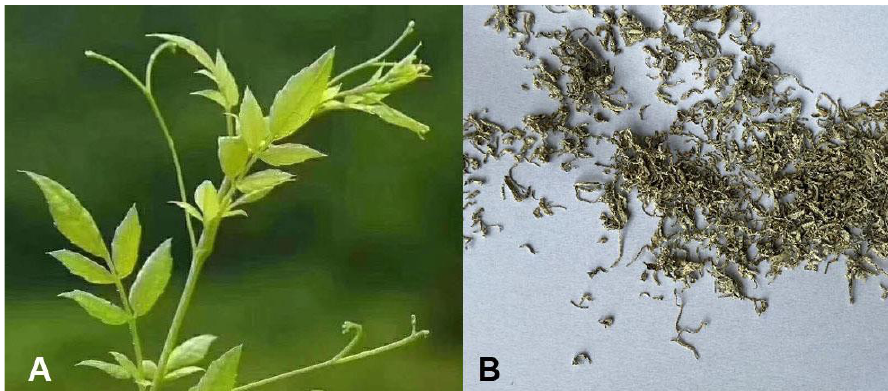
Figure 1. A photo of Ampelopsis grossedentata. ( A ) Fresh tender leaf; ( B ) dried tender leaf (vine tea or berry tea)